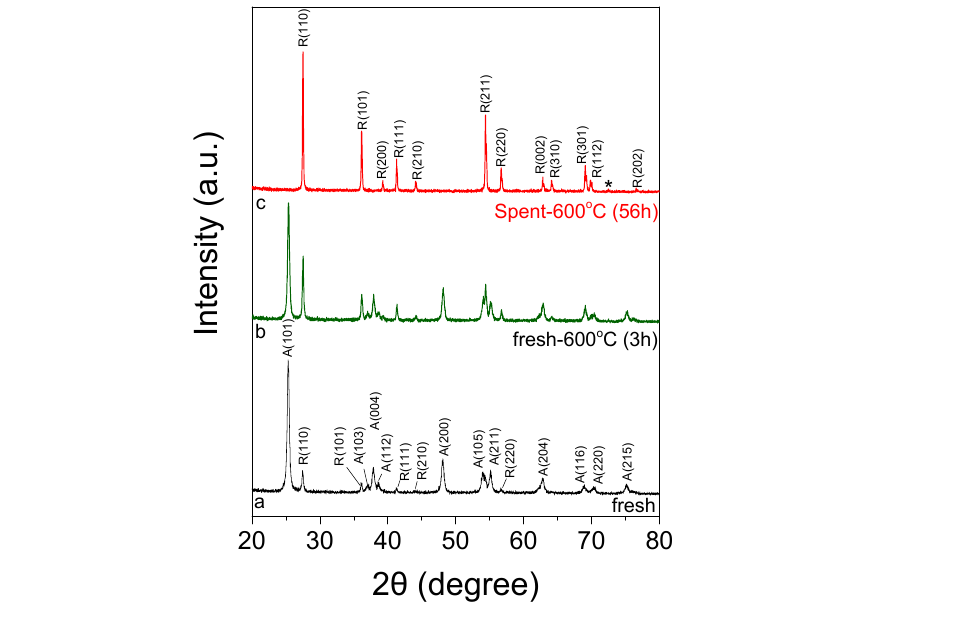
Figure 1. X-ray diffractograms of (a) fresh reduced, (b) fresh calcined in air at 600 °C followed by reduction at 300 °C and (c) spent 0.5%Rh/TiO 2 catalysts. Diffraction peaks denoted as “A”, “R”, and “*” are due to anatase TiO 2 , rutile TiO 2 , and graphite carbon phases, respectively. No peaks assigned to Rh planes were detected in the XRD spectra due to the low Rh particle size estimated according to H 2 chemisorption.